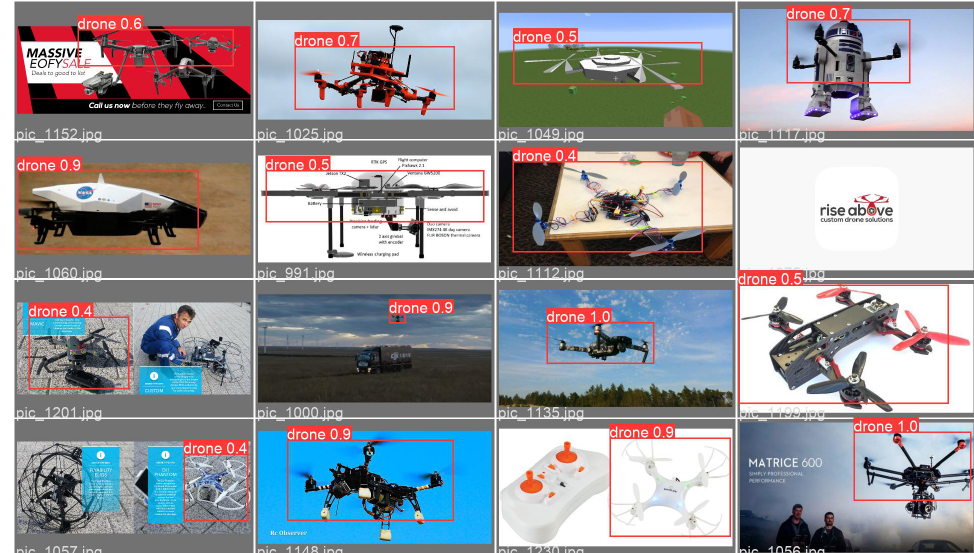
Figure 9. Drone detection using the proposed model supplied with images in the testing